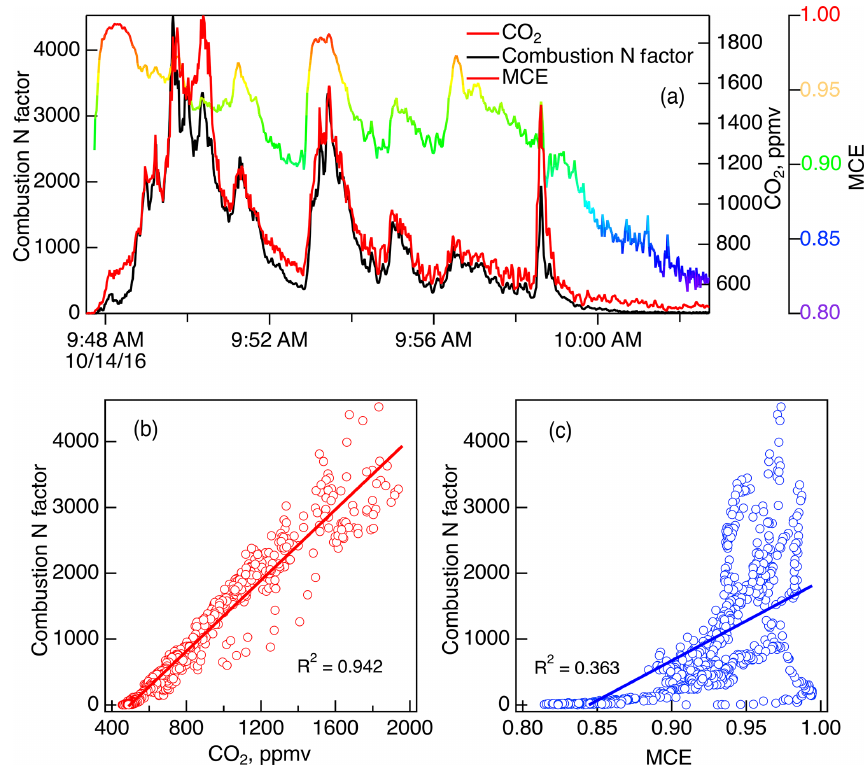
Figure 10. Comparisons of the N-PMF combustion factor (Comb-N) with (a) CO 2 and MCE for Fire 037 (ponderosa pine). Panel (b) shows the scatter plot of the Comb-N factor versus CO 2 , and panel (c) shows the scatter plot of Comb-N factor versus MCE.